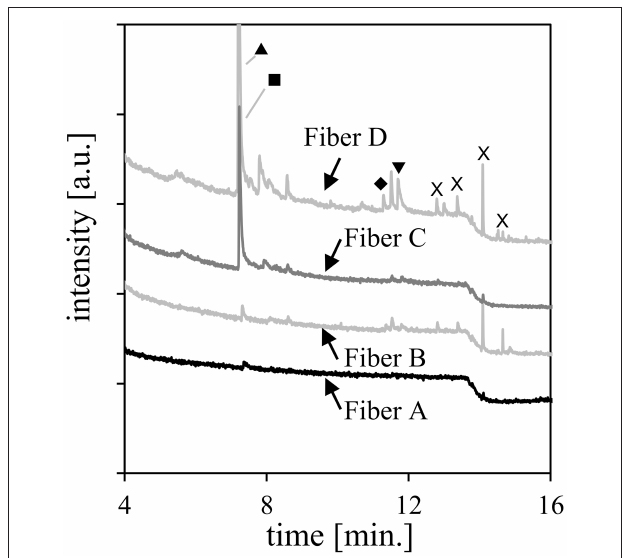
FIGURE 3 | Volatiles from P. aeruginosa PA01. (A) 30 ◦ C incubation, (B) 37 ◦ C incubation. Negative controls (labeled as “neg.”) were uninoculated and measured daily, (day 1 negative control only shown) for clarity. Peak identifications confirmed with co-elution of chemical standards are designated by symbols: N = 1-undecene; (cid:4) = 2-nonanone; (cid:7) = 2-undecanone; H =